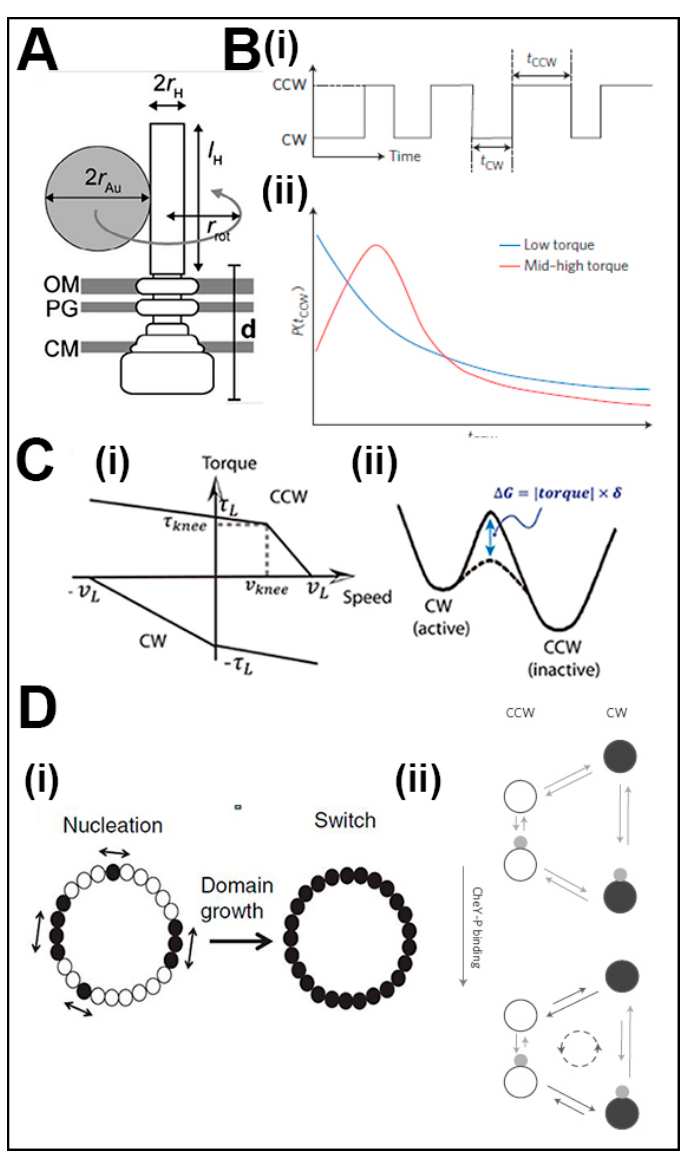
Figure 2. Advances in switch physiology. ( A ) Time-resolved motor rotation: Schematic of a motor rotation assay with a nanosphere conjugated to the hook connector contiguous with the rod and basal body (reproduced from [54] with permission) . ( B ) CW and CCW interval distributions: ( i ) Idealized time series of a motor alternating between CW and CCW rotation. (ii) Interval ( τ CW , τ CCW ) distributions measured under low and high torque (reproduced from [75] with permission). ( C ) Coupled energization and switching of rotation: ( i ) Torque velocity curves for CW and CCW rotation [63]. ( ii )